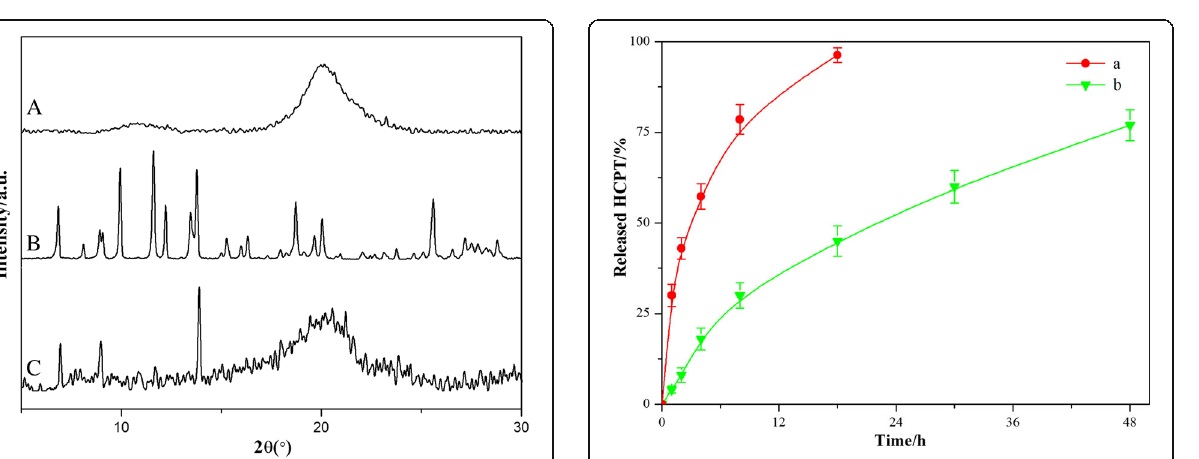
Fig. 5 The XRD patterns of ( a ) chitosan, ( b ) HCPT, and ( c ) MHNDs